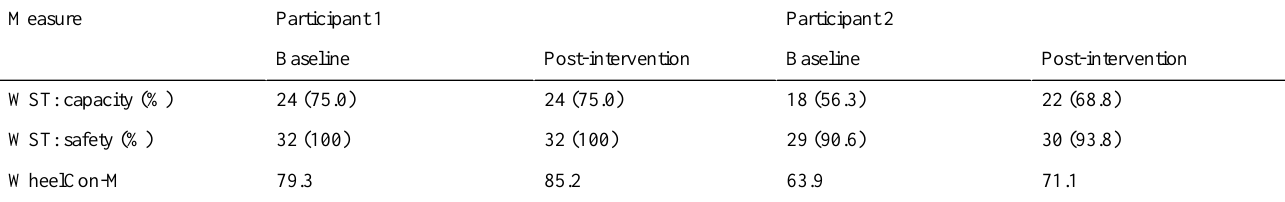
Table 1. Wheelchair skill capacity, safety, and self-efficacy scores.